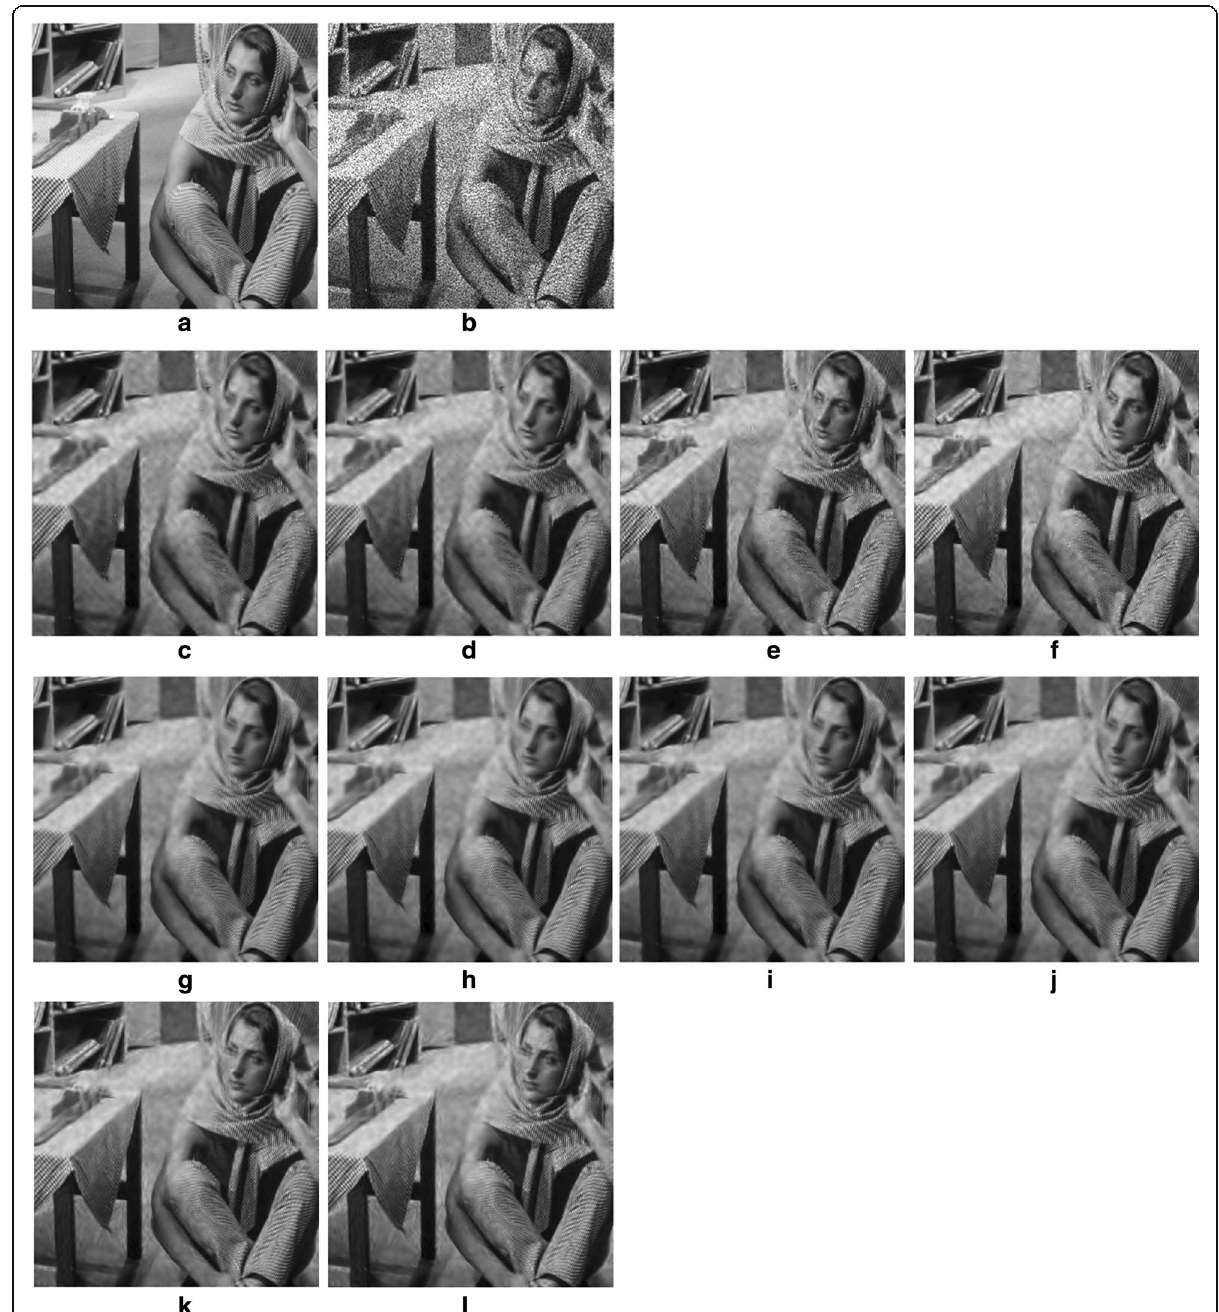
Fig. 8 a Barbara as the original test image, b noisy image ( σ 2 0 : 1), c – f despeckled images by B-SWT [30], WB-SWT, BI-SWT, WBI-SWT, and g – l N ¼ despeckled images by B-NSST [2], WB-NSST [27], BI-NSST(1), WBI-NSST(1), BI-NSST(2), and